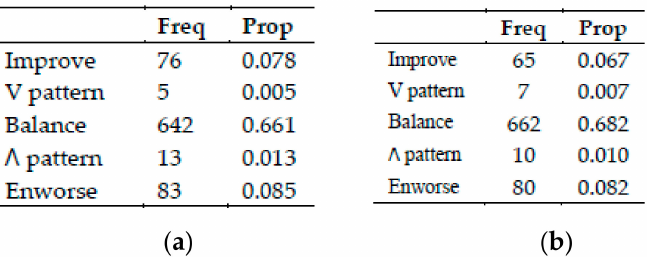
Figure 14. ( a ) Change patterns in familiar relationships with person living out of home; ( b ) Change of patterns in relationships with neigh-bours.